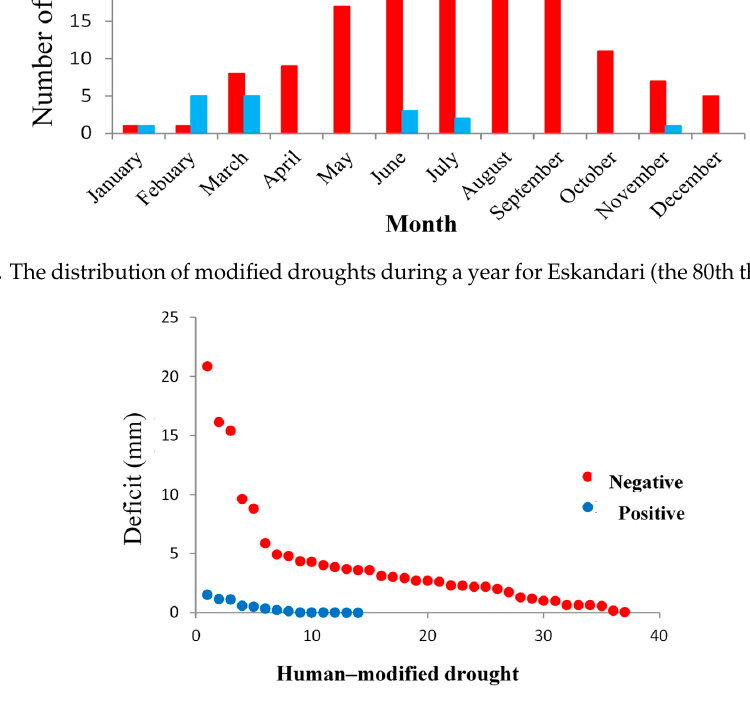
Figure 13. Deficit volumes of modified events for Eskandari (the 80th threshold value).